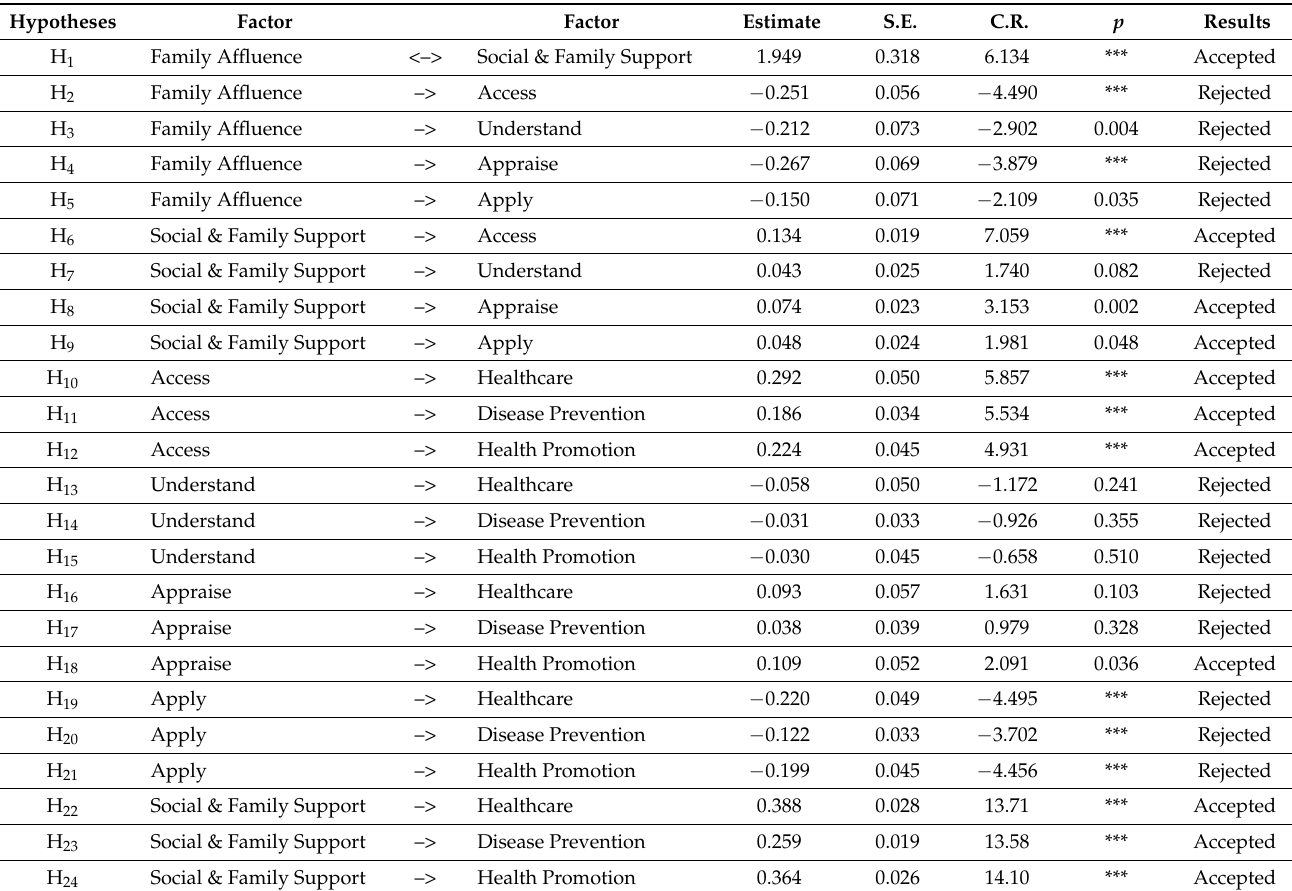
Table 2. Validation of the